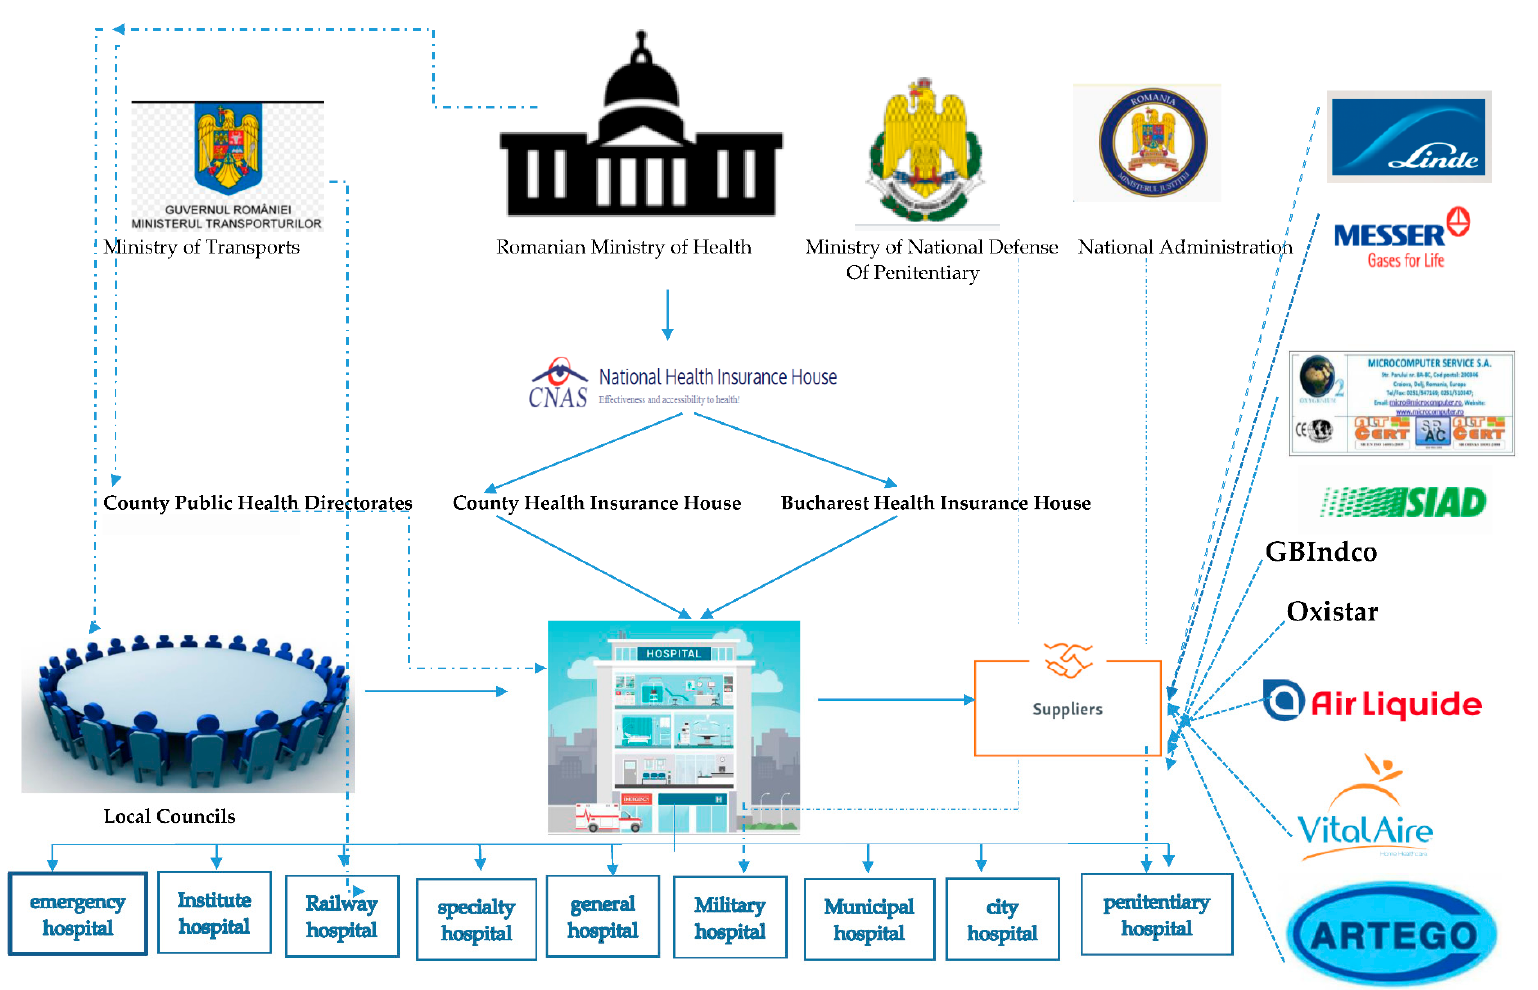
Figure 1. Main actors of the Romanian oxygen market.